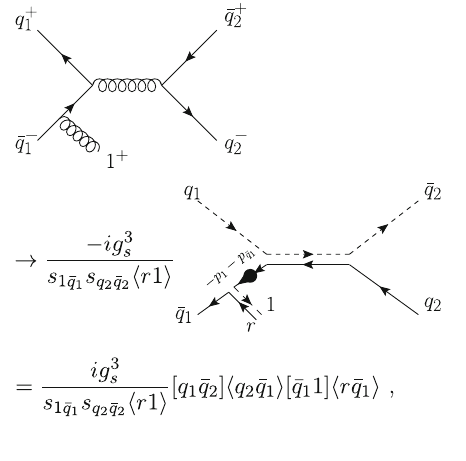
¯ q + ) multiplying the color factor t a 1 q + 1 + ¯ q − 2 1 1 2